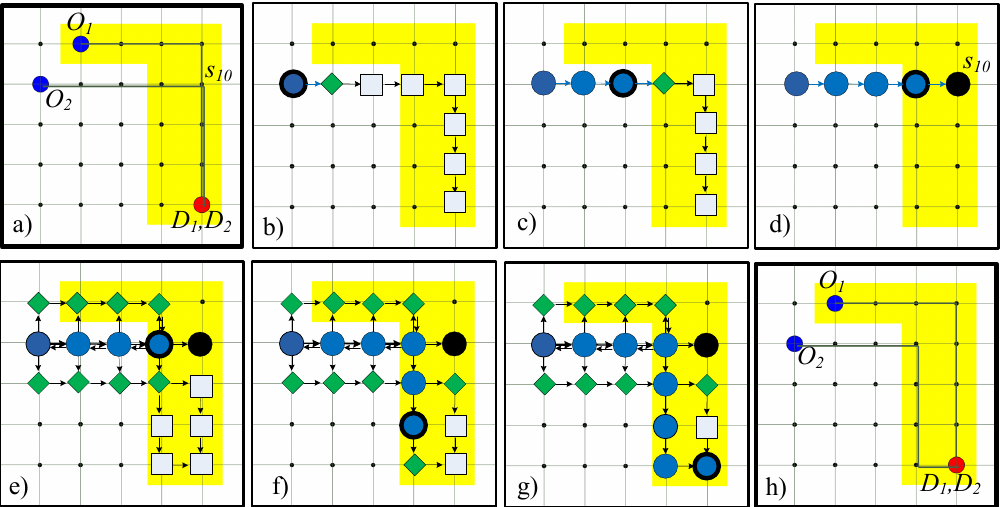
Figure 1. Illustration of traditional M* for two agents, where we show the evolution of the expanded graph G exp (circle), neighbor graph G nbh (diamond), and policy graph G φ (square) for Agent 2 as the M* algorithm proceeds. ( a ) Individually optimal paths; ( b ) the first expanded vertex; ( c ) the third expanded vertex; ( d ) collision occurs at vertex s 10 ; ( e ) sub-dimensional expansion; ( f ) search in the expanded space; ( g ) the destination of Agent 2 founded; ( h ) collision-free optimal paths for both